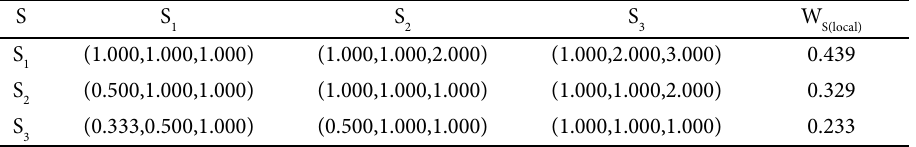
Table 7. Pair-wise comparison matrices and local weights for “S”-group